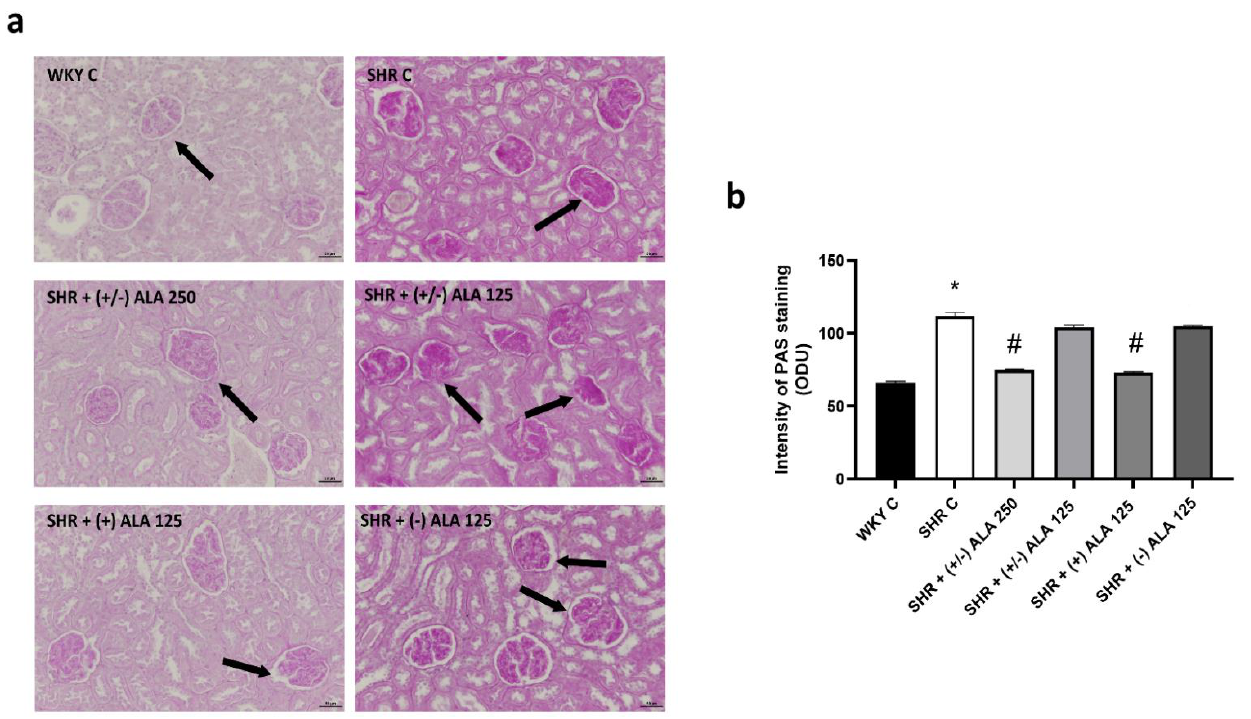
Figure 3. Renal glomerular morphology. ( a ) Renal tissue of WKY C, SHR C, SHR + (+/ − ) alpha lipoic acid (ALA) 250 µ mol/kg/day, SHR + (+/ − ) ALA 125 µ mol/kg/day, SHR + (+) ALA 125 µ mol/kg/day, SHR + ( − ) ALA 125 µ mol/kg/day were stained using periodic acid-Schiff (PAS) technique. Arrow: damaged glomerulus. Calibration bar: 50 µ m; ( b ) The bar graph shows the quantification of the intensity of PAS staining measured in optical density unit (ODU). Data are mean ± S.E.M. * p < 0.05 vs. WKY C; # p < 0.05 vs. SHR C.